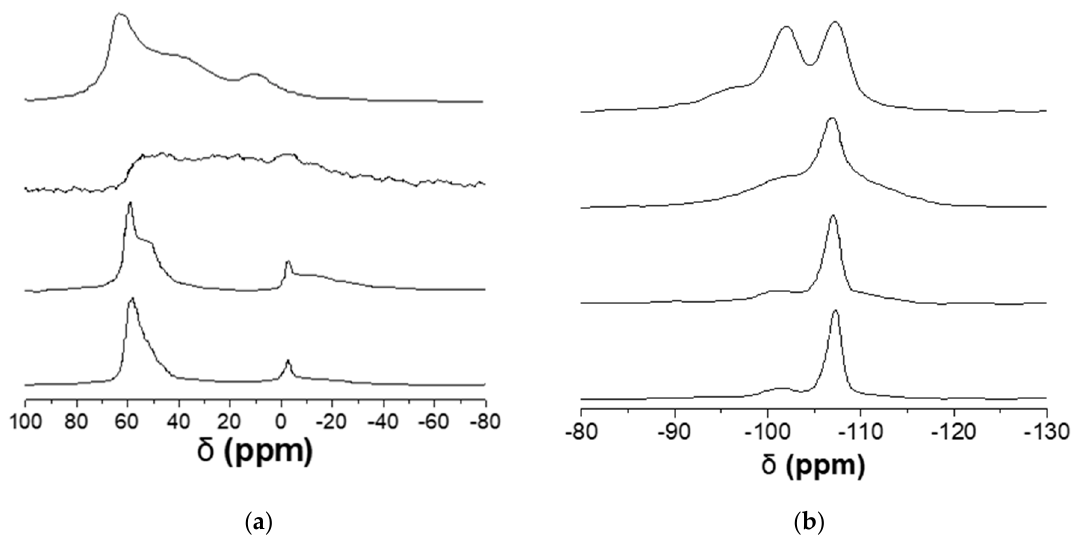
Figure 4. ( a ) 27 Al MAS-NMR and ( b ) 29 Si MAS-NMR of H-USY-0, H-USY-1, H-USY-2, and H-Y samples.